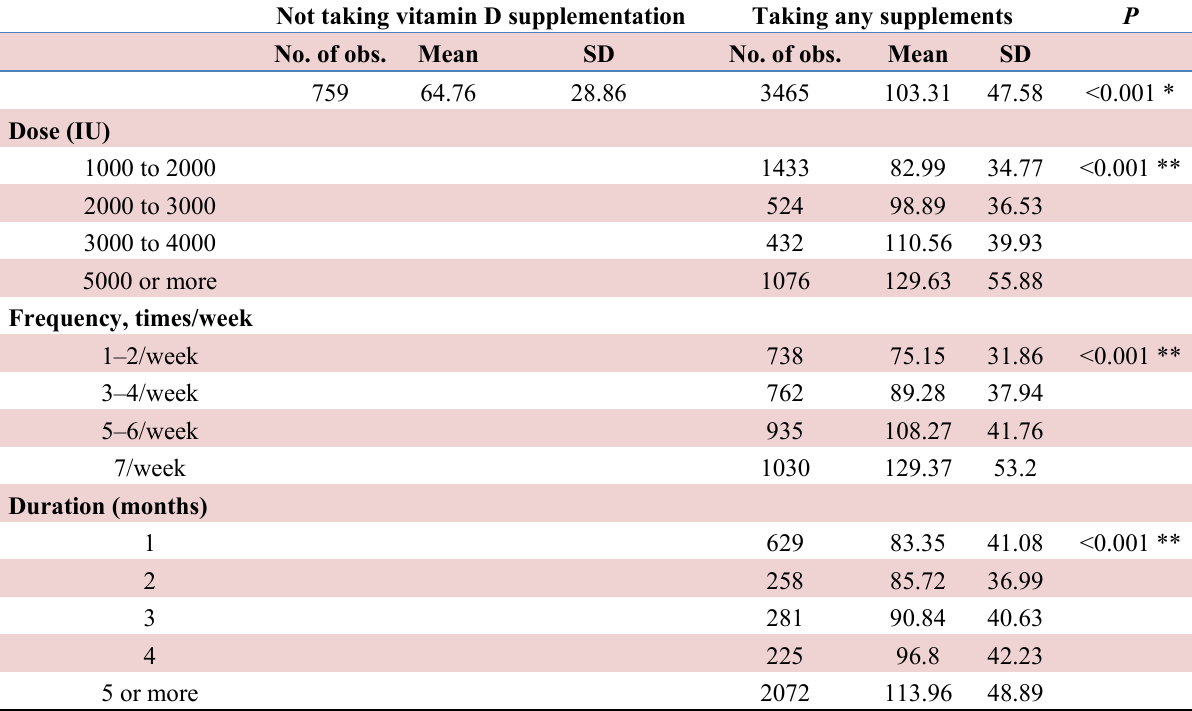
Table 2. Plasma 25-hydroxyvitamin D [25(OH)D] levels by dose, frequency and duration of vitamin D supplementation of 4224 study visits by 2714 participants. Not taking vitamin D supplementation Taking any